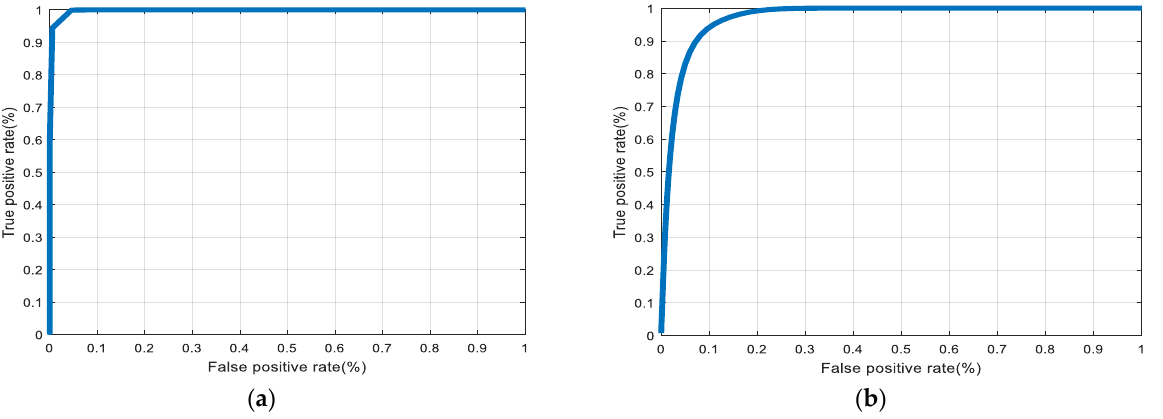
Figure 26. The ROC curves for the system using an encrypted kernel in the DWT domain with